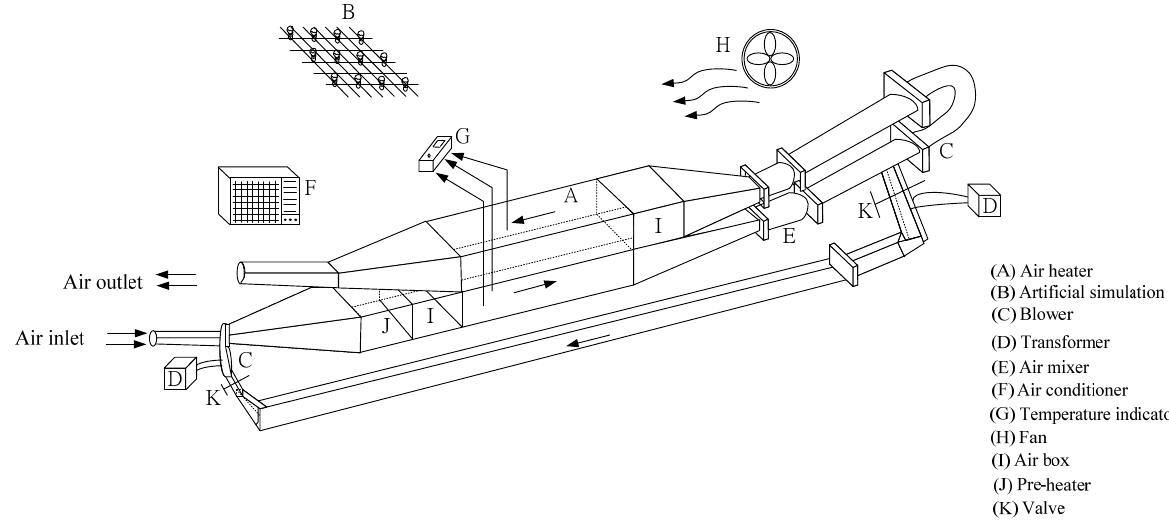
Figure 3. Schematic diagram of a double-pass solar air heater with artificial simulation.